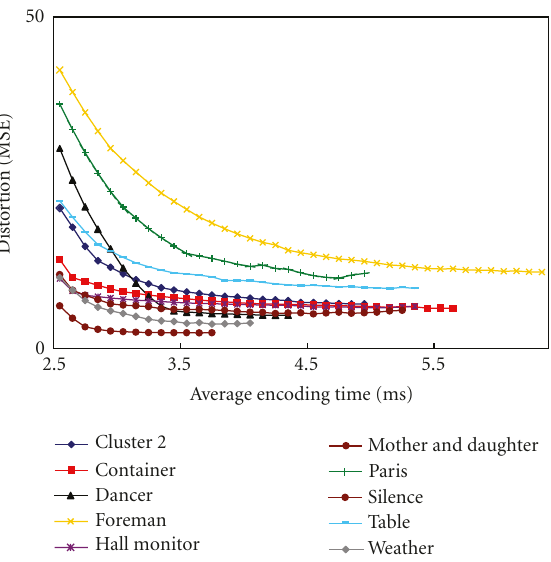
Figure 12: The relationship between average encoding time and distortion for video sequences in cluster 2.